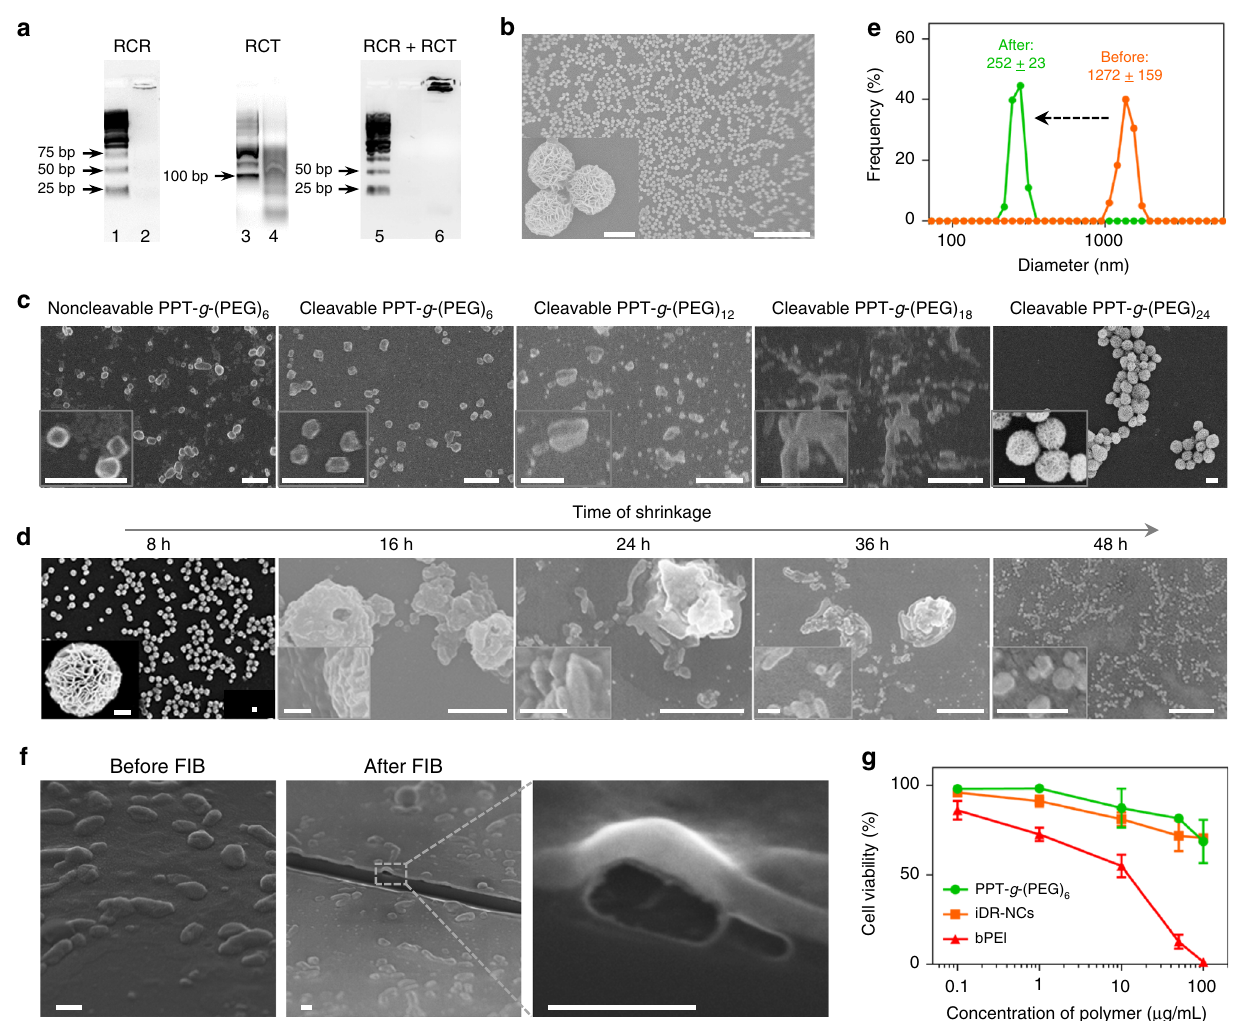
Fig. 2 Self-assembly and characterization of iDR-NC nanoadjuvants. a Agarose electrophoresis images showing that long tandem CpG and shRNA were generated by separate RCR and RCT, respectively, or by combined RCR/RCT in the same solution. Lane legends: 1: 25 bp DNA ladder; 2: RCR products; 3: 100 bp DNA ladder; 4: RCT products; 5: 25 bp DNA ladder; 6: products of combined RCR/RCT. b SEM images showing the morphologies of CpG-shRNA MFs generated after combined RCR/RCT for 24 h. Scale bar: 50 µ m; scale bar in inset: 1 µ m. c SEM images showing the products after incubating CpG-shRNA MFs with different PPT- g -PEG derivatives (2.5 mg/mL) for 48 h. Scale bars: 2 µ m; scale bars in inset: 1 µ m. d SEM images showing the products after incubating CpG-shRNA MFs with 2.5 mg/mL PPT- g -(PEG) 6 for a series of times. Scale bars: 2 µ m; scale bars in inset: 500 nm. e DLS graph showing the particle sizes before (MFs) and after (iDR-NCs) shrinkage by 2.5 mg/mL PPT- g -(PEG) 6 . f SEM images showing iDR-NCs before and after FIB. FIB exposed the interior hollow structures of NCs. Scale bar: 500 nm. g MTS assay results showing less cytotoxicity of PPT- g -(PEG) 6 and iDR-NCs